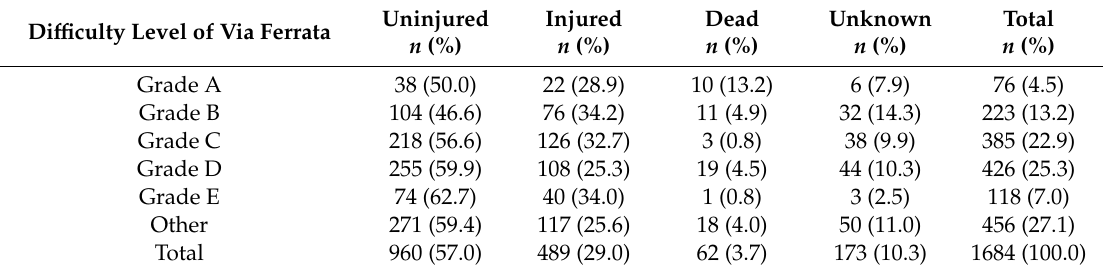
Table 3. Di ffi culty level of via ferratas in relation to injury severity in Austria from 1 November 2008